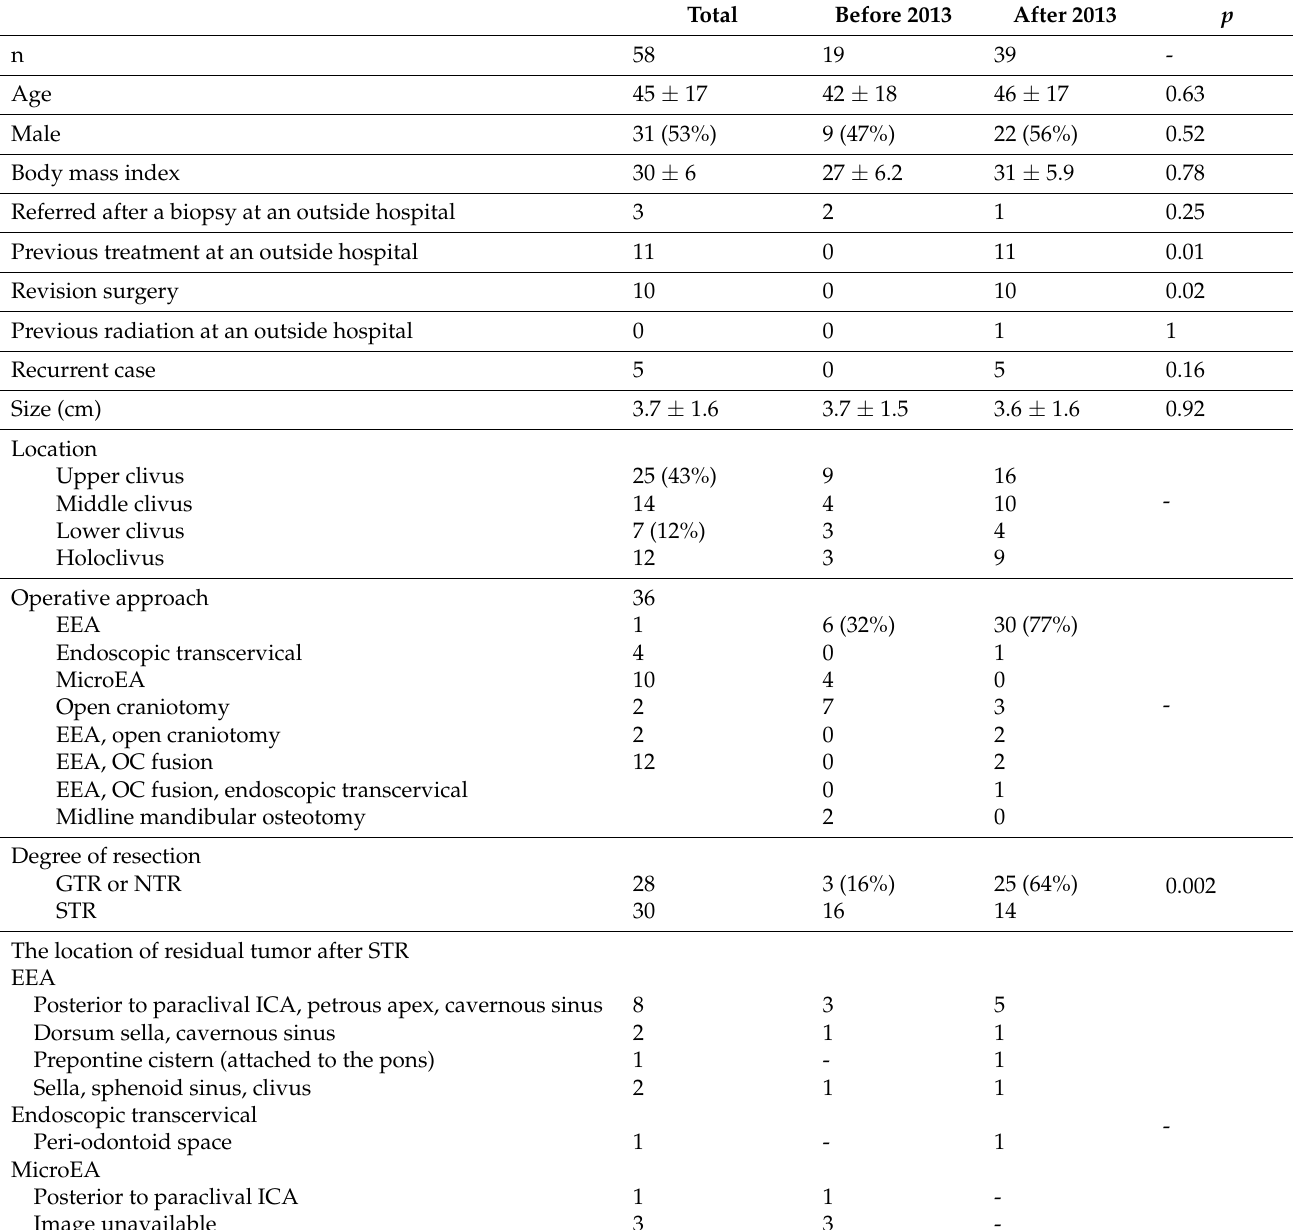
Table 1. Characteristics of the patients at baseline and treatment